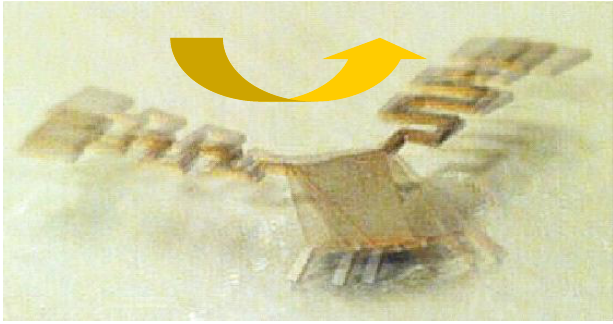
Figure 7. Still shots illustrating the robot turning counter-clockwise at 1,090 Hz.